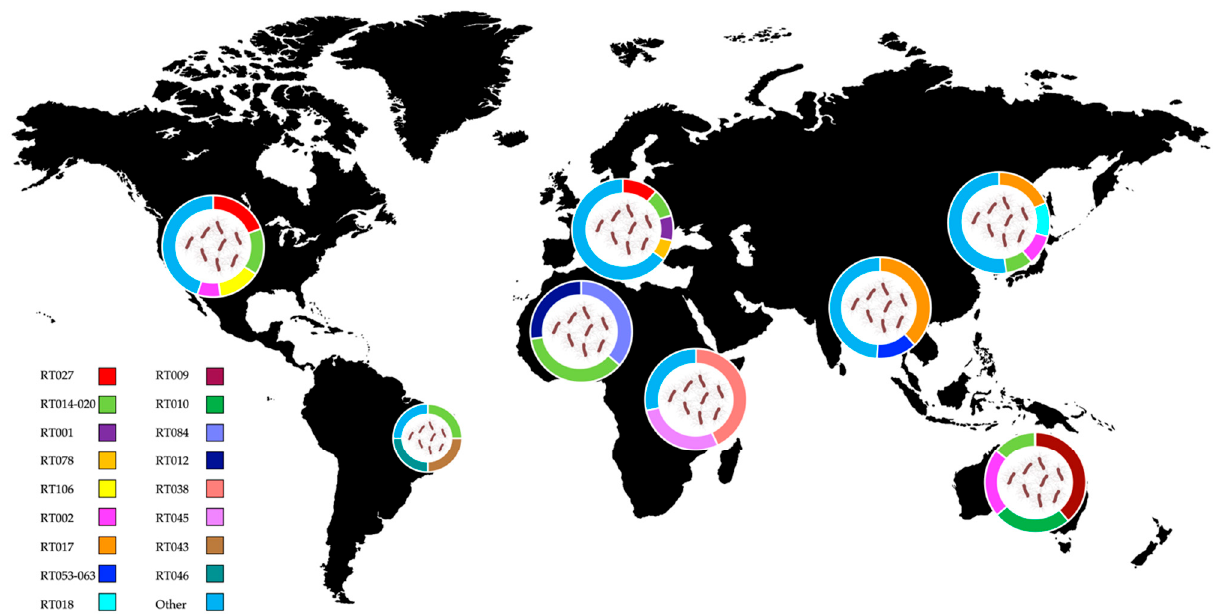
Figure 1. Distribution of C. difficile ribotypes in the United States, South America, Europe, North and Central Africa, Asia and Australia. Data are shown in pie charts as percentage, from studies covering different countries [93–95] or single country [96–100]. The smaller pie chart is representative of a single hospital study. The world map was obtained from Freepik.com. See also Table S1 for the toxin gene profile of listed